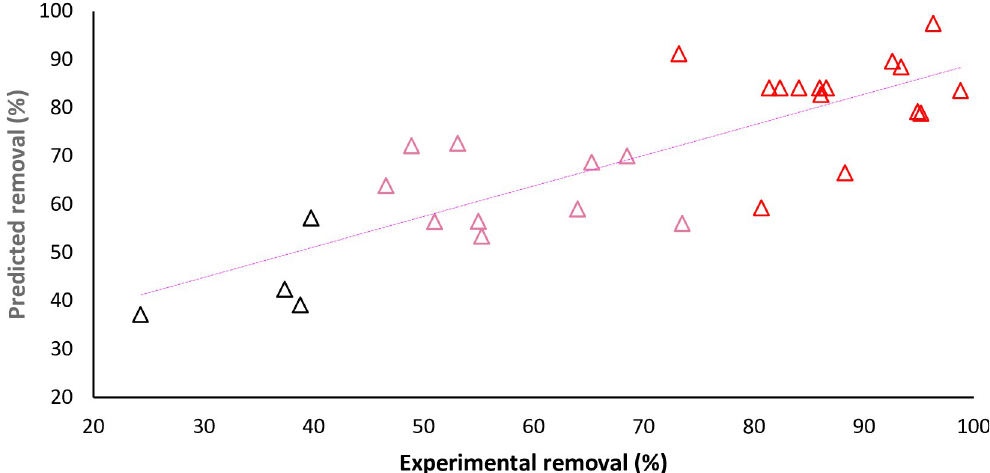
Fig 5. Experimental vs model predicted efficiency for CIP removal by